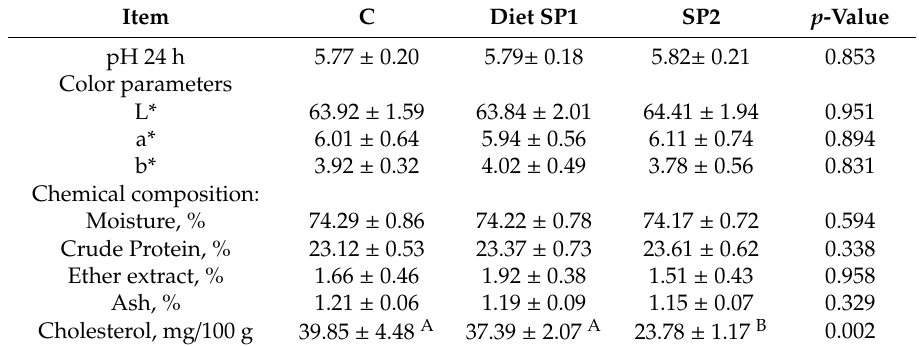
Table 5. Physical and chemical parameters of Semimembranosus muscle of rabbits fed the control diet (C) and diet supplemented with 3 g/kg (SP1) and 6 g/kg (SP2) of brown seaweed and plant polyphenols.